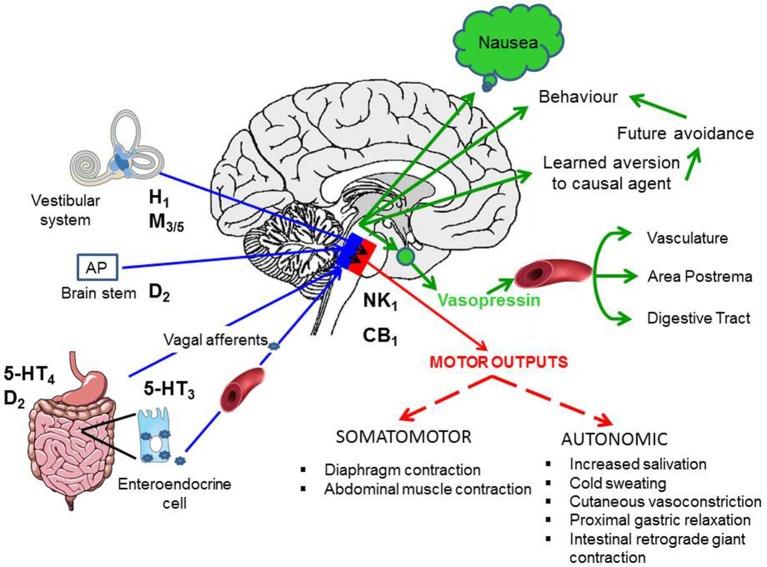
Summary of the pathways responsible for the induction of nausea and vomiting (blue arrows), the integrative regions in the brain stem (blue box indicates dorsal brain stem and nucleus tractus solitarius in particular) and the output pathways for nausea (green) and the motor outputs for vomiting (red box indicates the pathways in the ventral brain stem). See text for details of pathways. CB1, cannabinoid1 receptor; D2, dopamine2 receptor; H1, histamine1 receptor; M3/5, muscarinic3/5 acetylcholine receptor; 5-HT3-5-hydroxytryptamine3 receptor; 5-HT4-5-hydroxytryptamine4 receptor; NK1, tachykinin neurokinin 1 receptor. Adapted and modified from Stern et al. (2011).